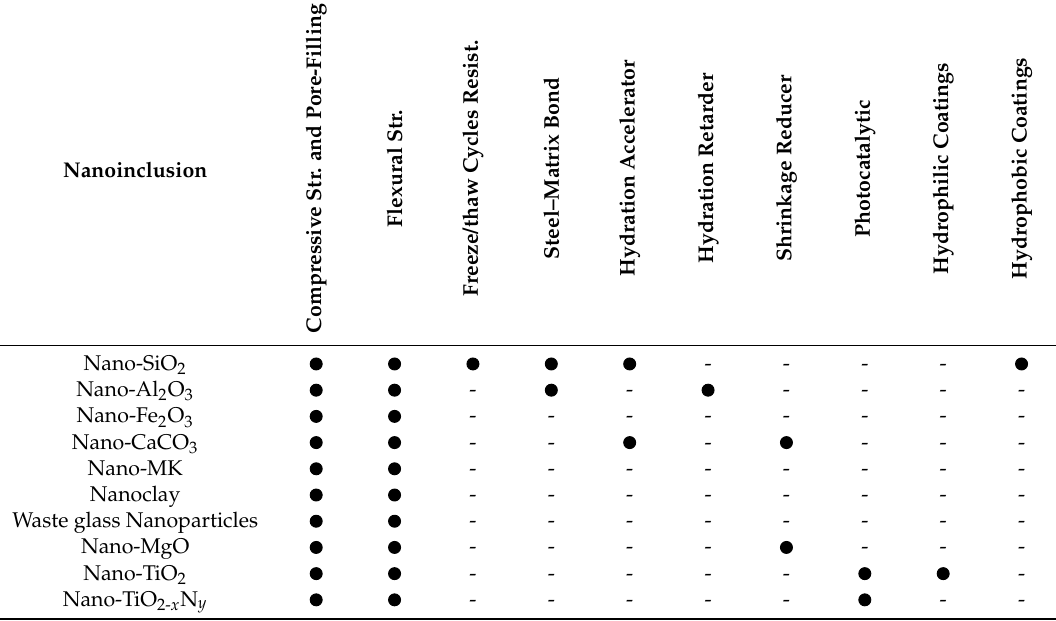
Table 4. Most remarkable properties enhanced or provided by